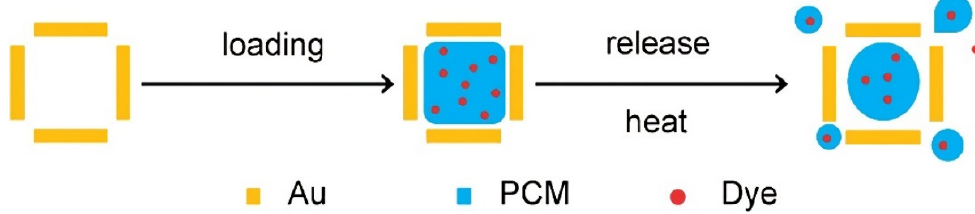
Figure 4. Schematic illustration of temperature-responsive AuNCs loaded with dye-doped PCM. Reprinted/adapted with permission from Ref. [52]. Copyright 2011, American Chemical Society.